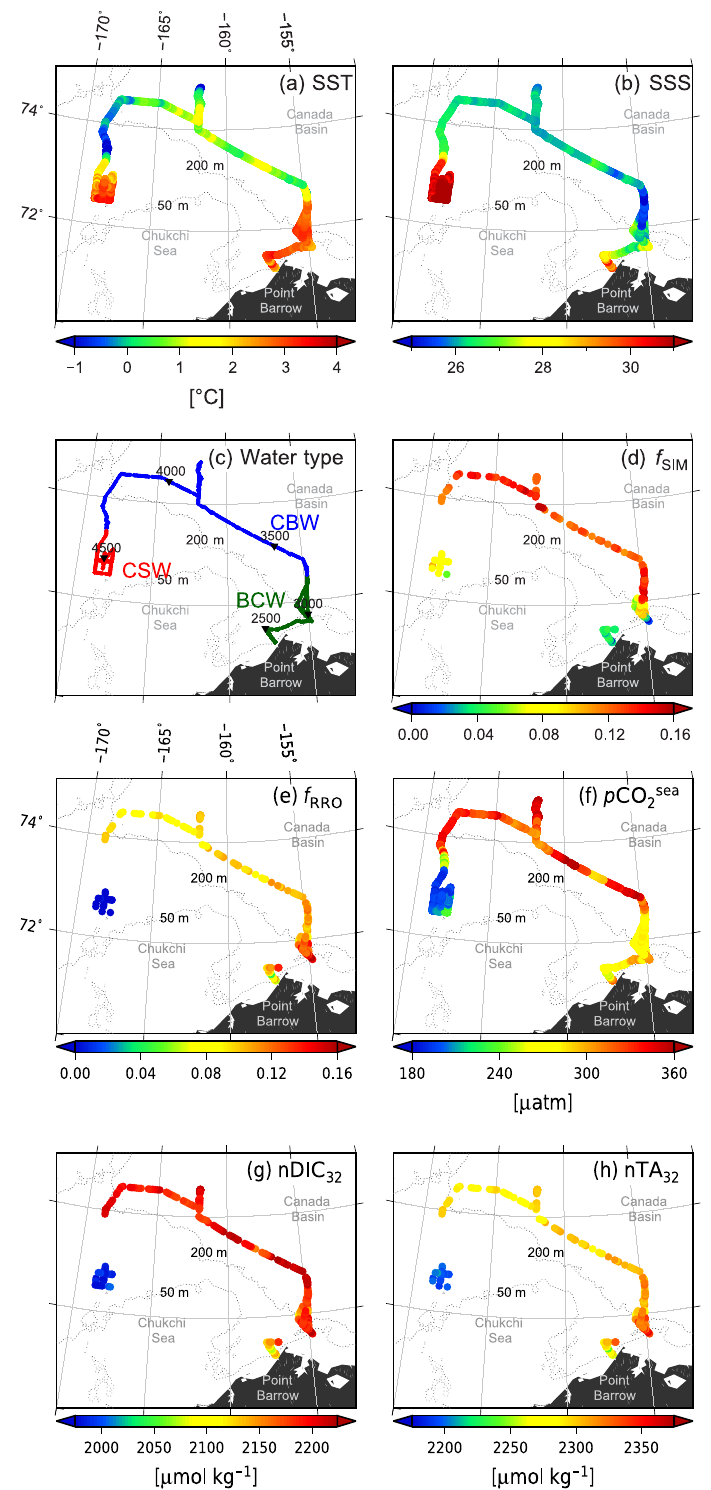
Figure 3. Surface water properties along the track of cruise MR13-06 from 4 to 11 September 2013. (a) Sea surface temperature (SST); (b) sea surface salinity (SSS); (c) BCW (Barrow coastal water), CSW (Chukchi Sea water), and CBW (Canada Basin water) water types accord- ing to SST and SSS. The numbers over triangles indicate distance sailed from Dutch harbor, Alaska, USA (km). (d) f SIM . (e) f RRO . (f) p CO sea . (g) nDIC 32 = DIC /S · 32, where DIC normalized is to S = 32. (h) nTA 32 = TA /S · 32, where TA is normalized to S = 32. 2 Dotted lines indicate 50 and 200m